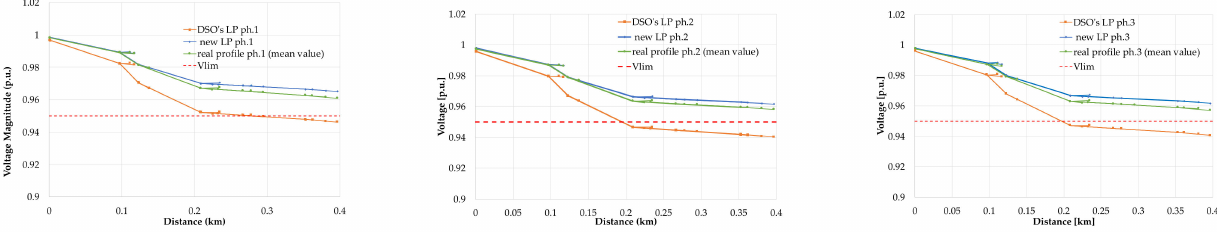
Figure 19. Voltage profile of feeder F_4 in one hourly interval: 11:00 a.m. of the winter working day (mean of real day values in green, distribution systems operator (DSO)’s LPs in orange, and new LPs in blue; voltage limit in red).